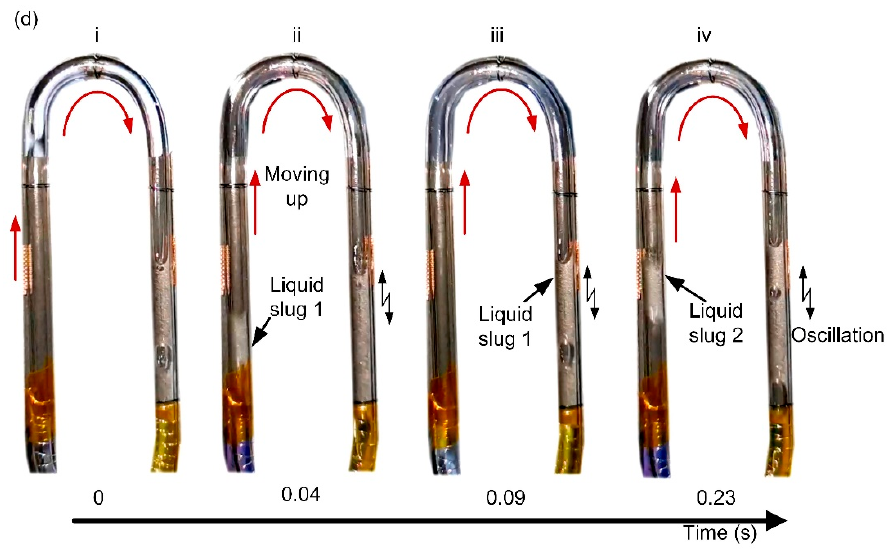
Figure 3. Flow inside the axial-rotating SLOHP filled with acetone under 22,750 W/m 2 : ( a ) at static state; ( b ) at 60 rpm rotating speed; ( c ) at 150 rpm rotating speed; and ( d ) at 300 rpm rotating speed.